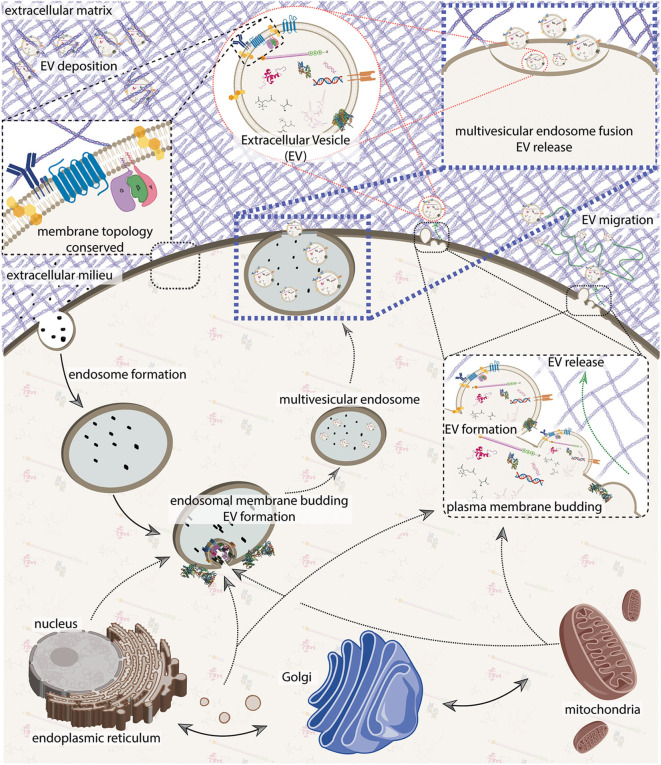
An integrative model of extracellular vesicle (EV) biogenesis. A sample of plasma membrane and extracellular materials is internalized through the endocytic pathway, forming an endosome. The nucleus, endoplasmic reticulum, Golgi, and mitochondria generate an interconnected secretory network that can deliver cellular contents either to the endosome or to the plasma membrane. Secretory machinery localizes at either the endosome or at the plasma membrane and contents are loaded into the nascent EV while membrane budding away from the cytosol occurs. Membrane scission occurs, and at the plasma membrane, EVs are immediately released. In the endosomal pathway, nascent EVs are kept as intralumenal vesicles until the multivesicular endosome fuses with the plasma membrane to release its contents. Cell membrane topology and constituents are generally conserved. On release, EVs can either bind to or navigate through the extracellular milleu which can include matrix proteins. See Figure 4 for more detail on EV composition. The figure was prepared in part using BioRender.com.